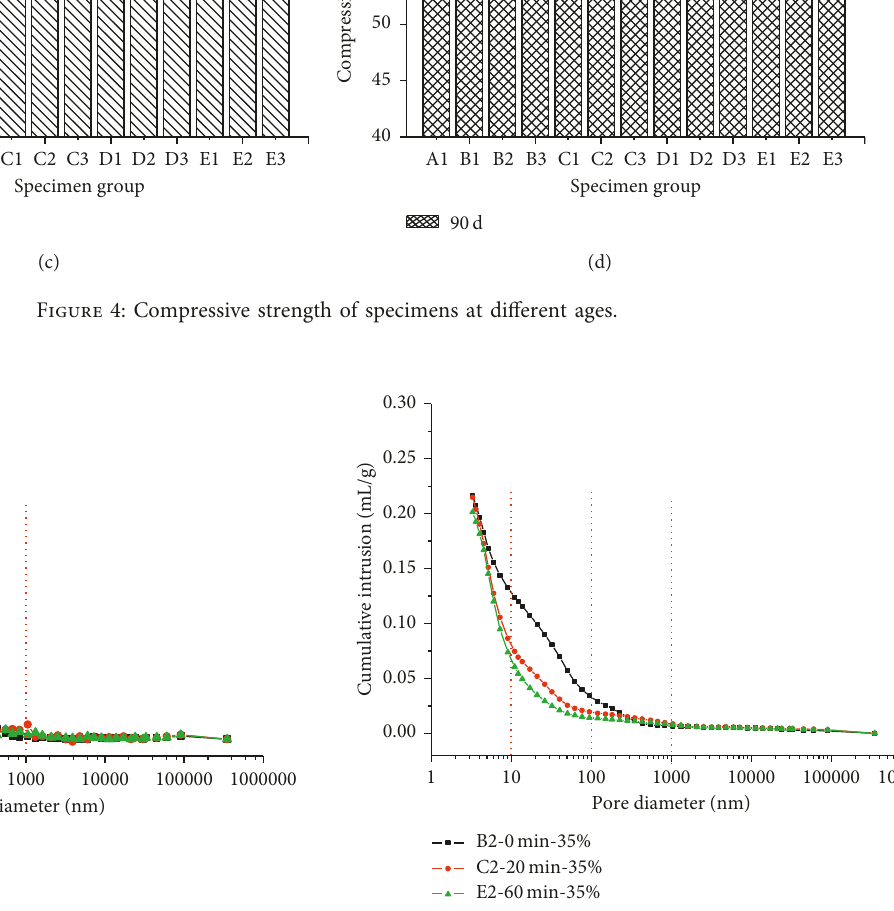
Figure 5: Pore size distribution curves of specimens with 35% of UFSS at 28 days.